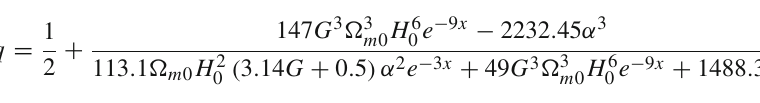
In Figs.1, 2 and 3 the evolution of equation of state of dark energy in our model, the deceleration parameter (45) and evolution of fractional energy density of matter and dark energy are plotted, respectively. As shown, dark energy treats like cosmological constant in present Universe while in high redshiftitbehavessuchasmatter.Incomparisonwith (cid:14) CDM model our model presents dark energy as quintessence fluid for α (cid:10)= 0. Also setting Rényi parameter α ∼ 10 2 − 10 2 . 25 when H 0 = 67 . 4, (cid:15) m 0 = 0 . 31 and G = 6 . 67 × 10 − 11 [34] gives transition point z T = 0 . 52 − 0 . 85 which satisfies observations [35]. In presence of α , transition point z T shifts to present Universe which gives robust tool with respect to (cid:14) CDM theory to fix model with last and future